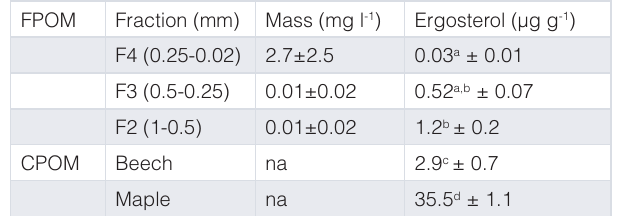
Table 1. Mass of FPOM fractions (mg l -1 , mean ± SD; n = 3) and ergosterol concentrations (µg g -1 , mean ± SD) of FPOM and beech (Utopia Lake) and maple (Boss Brook leaves). Ergosterol values were evaluated by ANOVA (p < 0.0001), followed by Tukey- Kramer. Averages with same letter are not significantly different (p > 0.05). Based on Dataset 1 and Dataset